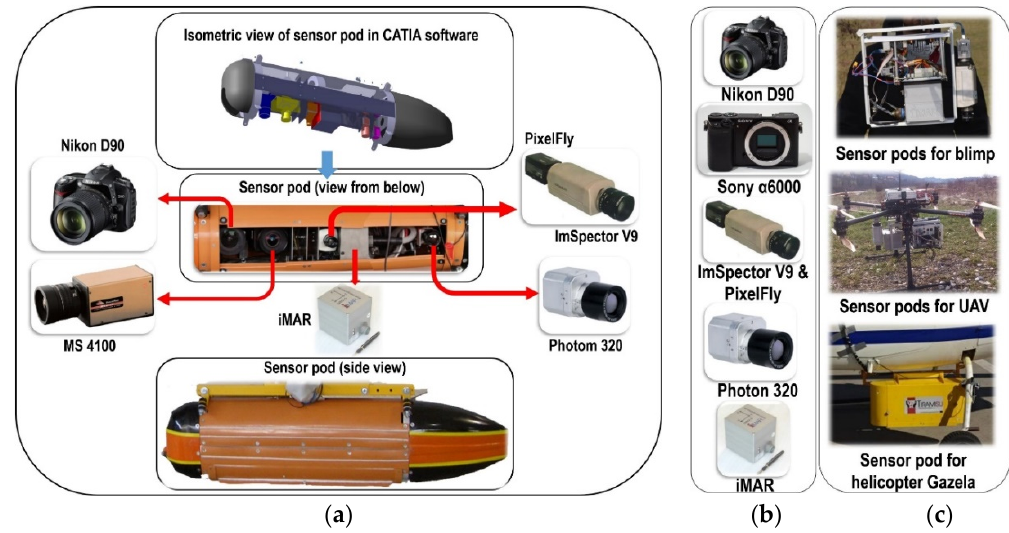
Figure 8. ( a ) Example of the first sensor pod designed and made with associated sensors for the Mi-8 and Bell-206 platforms. ( b ) Sensor used and ( c ) examples of a sensor pod designed and made for blimp (top), unmanned aerial vehicle (UAV, in the middle) and helicopter Gazela (bottom). Table 2. Summarized results of tests performed in different operational conditions for the following platforms: Mi-8 and Bell-206 helicopters, RPAS X8 MR, RPAS 8 ZERO, and a blimp with hyperspectral line scanner V9, multirotor UAV with hyperspectral frame sensor UHD-185.